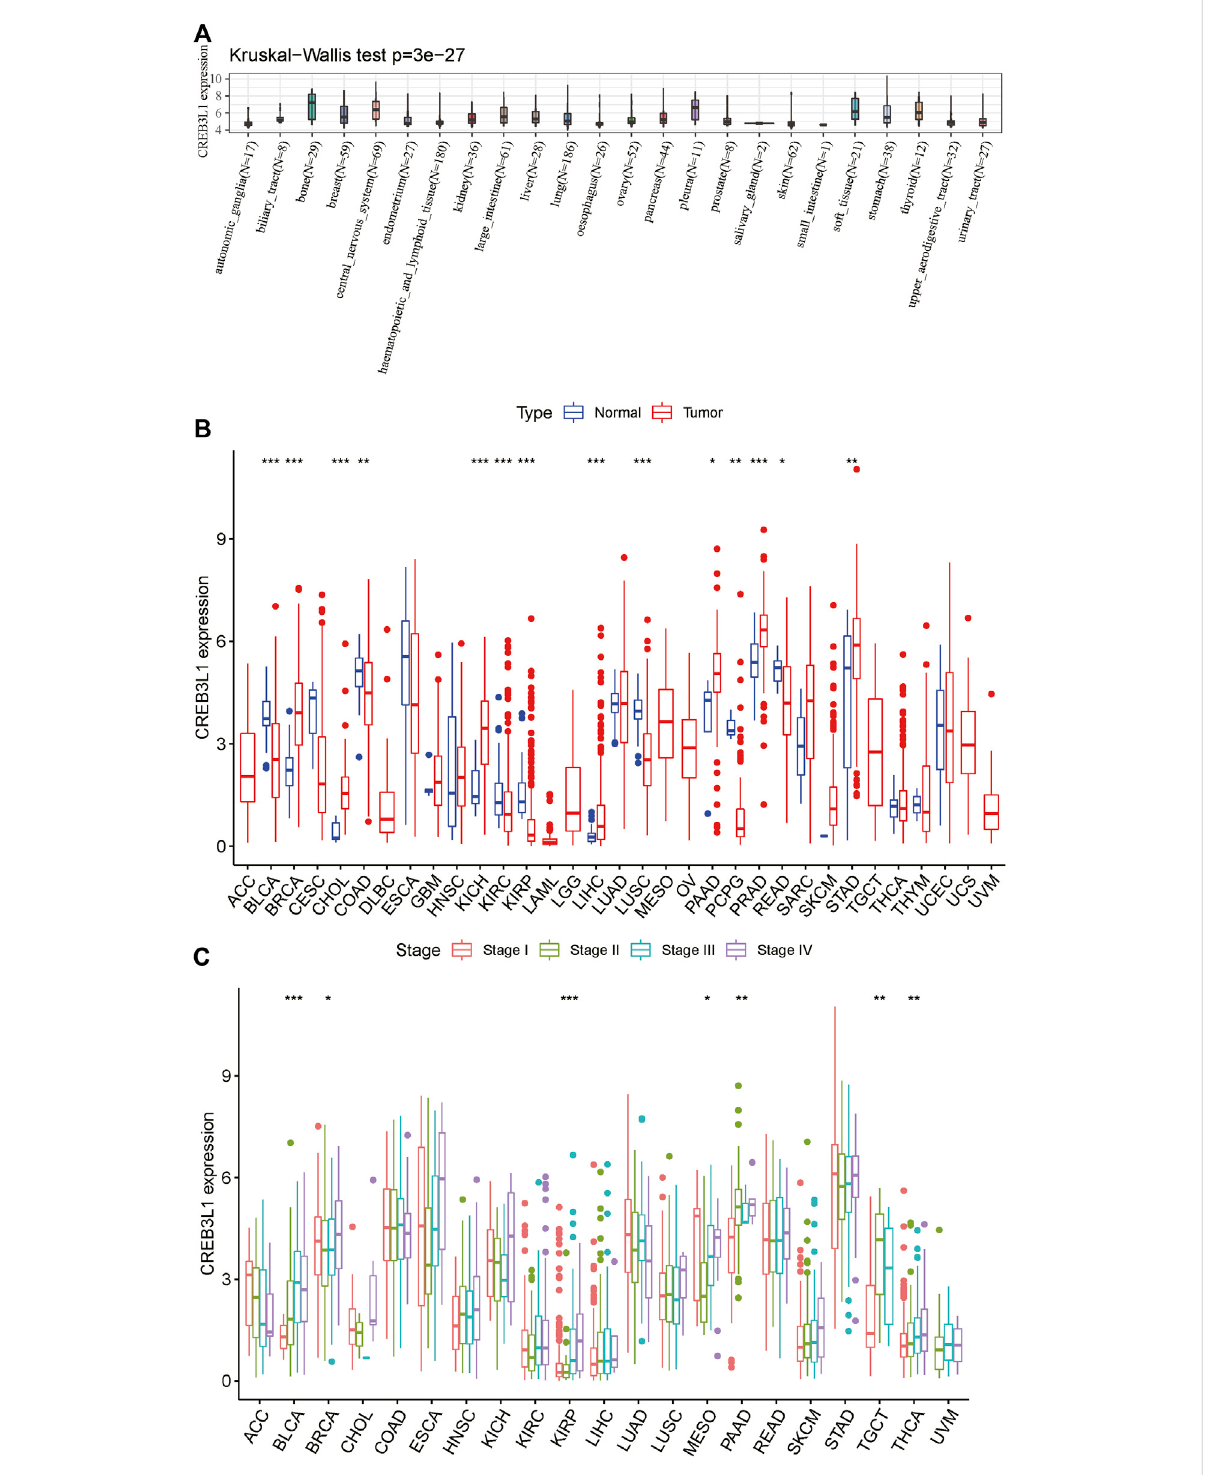
FIGURE 1 TheexpressionpatternofCREB3L1. (A) CREB3L1expressionin24cancercelllinesfromCCLEdatabase. (B) ComparisonofCREB3L1expression between cancer and matched normal samples from TCGA database. (C) CREB3L1 expression in patients with different WHO stages in pan-cancer from TCGA database. * p < 0.05, ** p < 0.01, *** p <